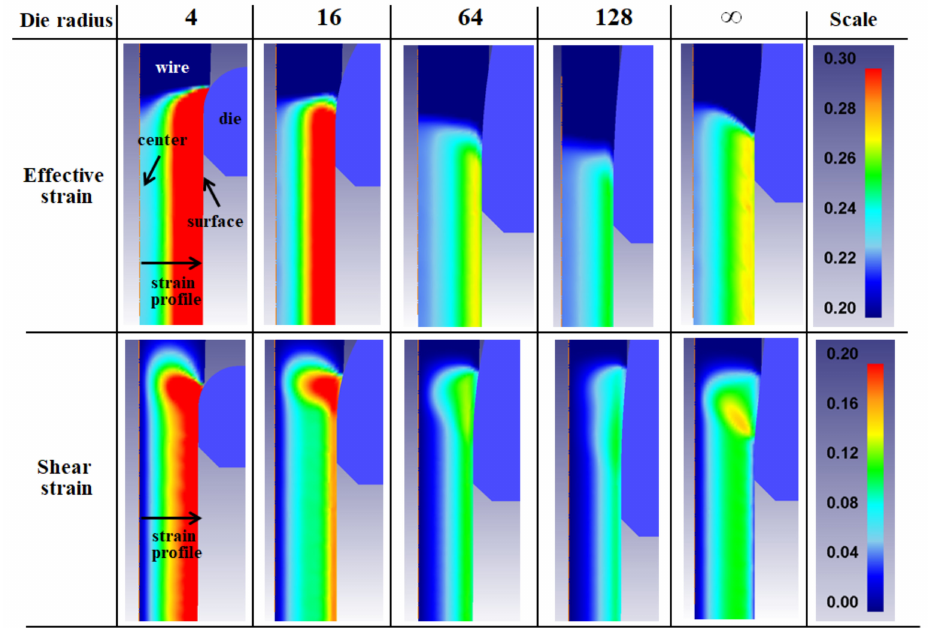
Figure 6. Comparison of contour in effective strain and shear strain of the wire with the die radius.